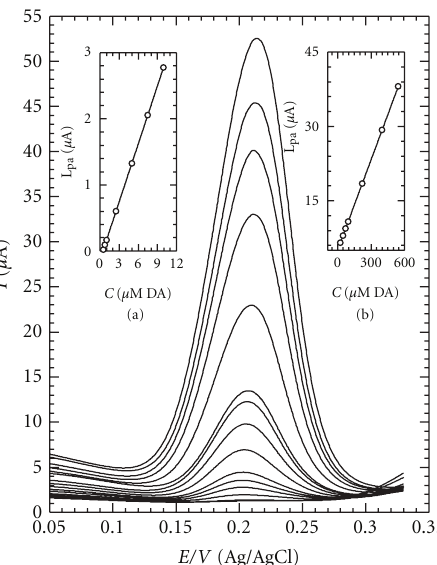
Figure 6: Di ff erential pulse voltammograms recorded in the presence of di ff erent concentration of DA in 0.1 M NH 4 NO 3 at pH 5. The insets show the two linear range calibration curves extracted from the voltammograms; (a) lower range and (b) upper range. See the text for